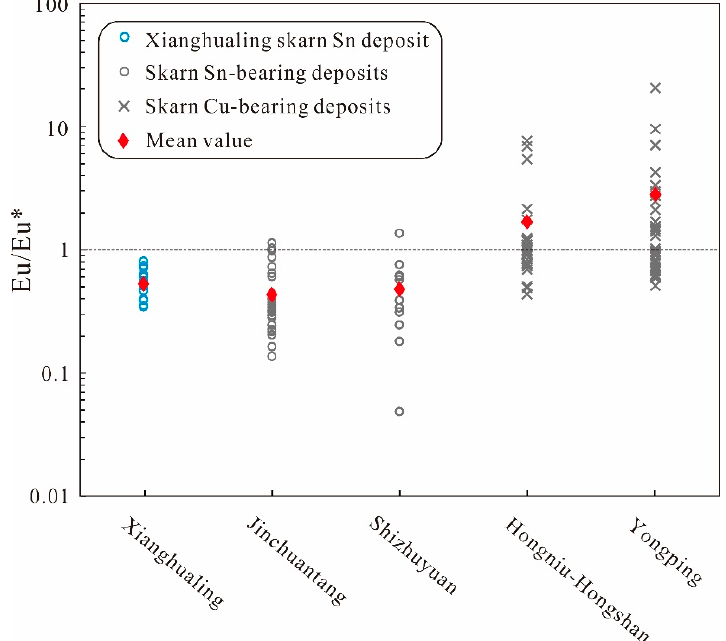
Figure 7. Garnet Eu/Eu* ratios of Xianghualing and several other skarn deposits. Note: The compiled skarn Sn-bearing deposits include Jinchuantang skarn Sn–Bi deposit [53] and Shizhuyuan